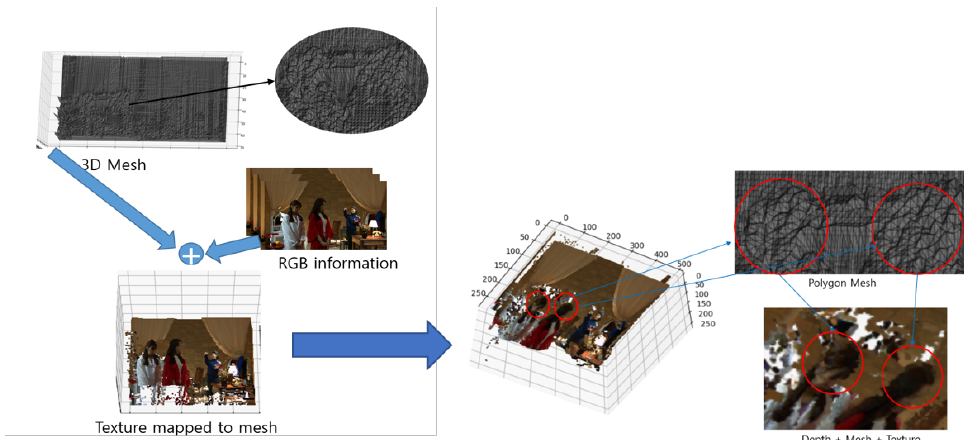
Figure 13. Texture is mapped to the points, the locations of which are matched to those of the generated